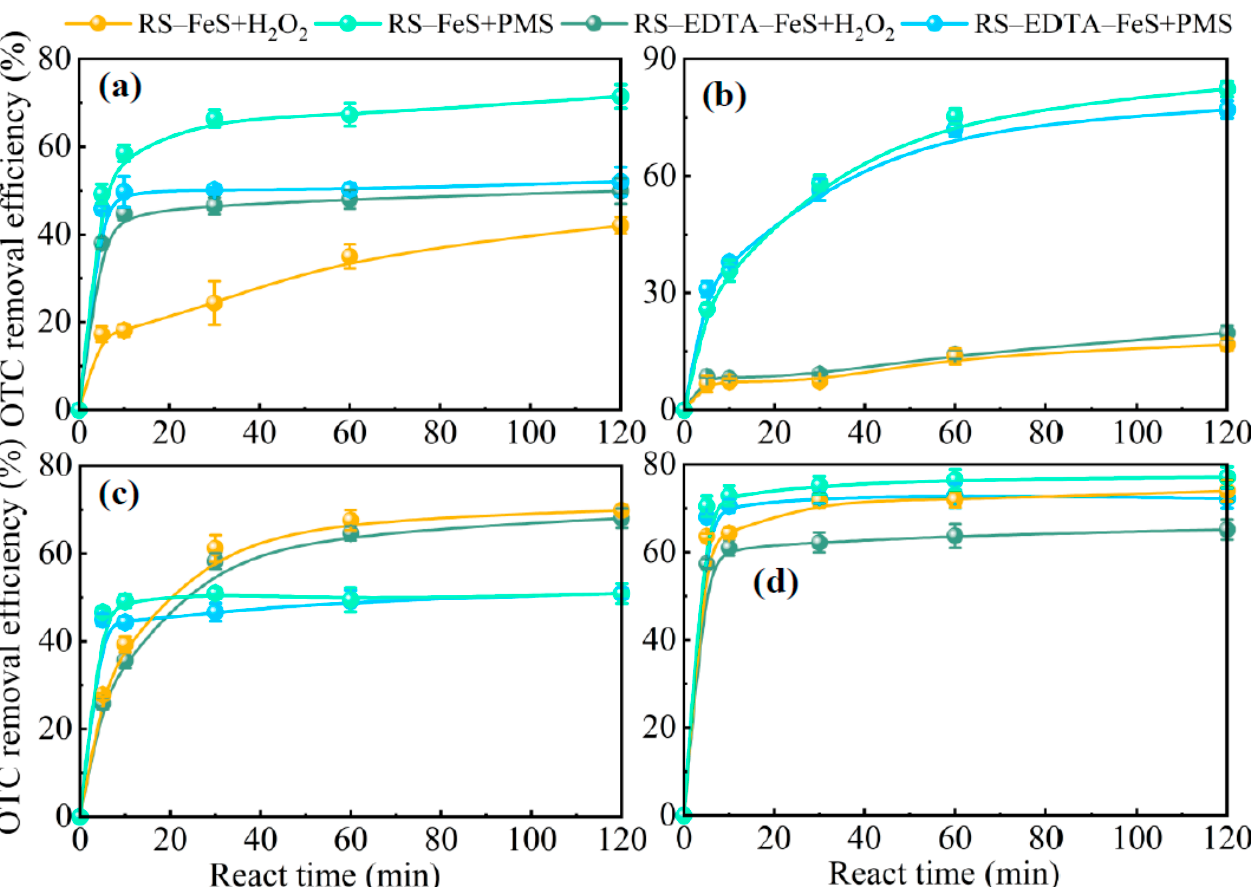
Figure 7. The effect of coexisting CH 3 OH ( a ), Na 2 CO 3 ( b ), fulvic acid ( c ), and NaCl ( d ) substances on OTC degradation from the RS–FeS/PMS, RS–EDTA–FeS/PMS, RS–FeS/H 2 O 2 , and RS–EDTA– FeS/H 2 O 2 system (C 0 = 20.00 mg L − 1 , [PMS] = 0.20 g L − 1 , [H 2 O 2 ] = 6.60 mM, initial pH in H 2 O 2 system = 3.00, initial pH in PMS system = 6.00).